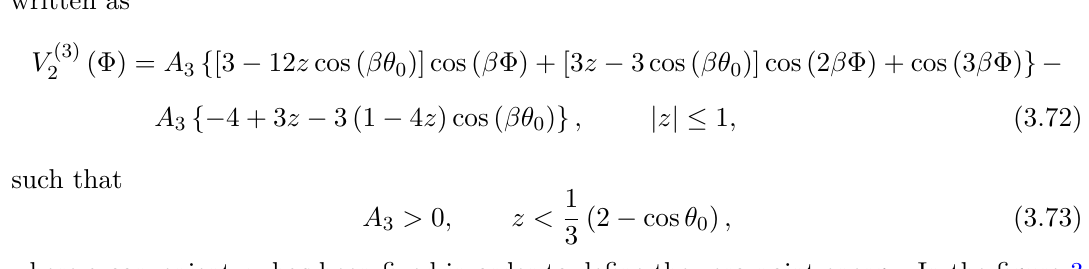
and vacua nθ o , n ∈ ZZ 3